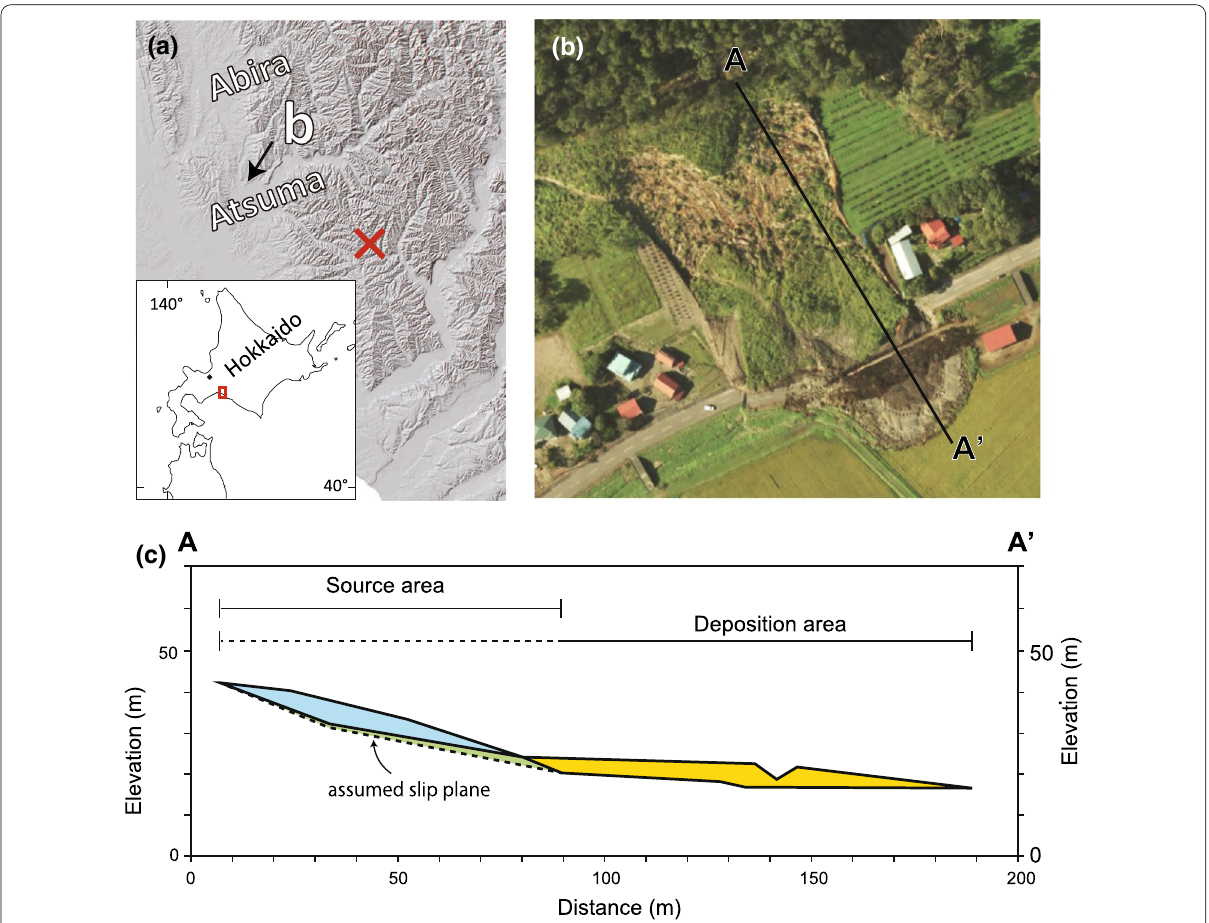
Fig. 1 a Location of the epicenter of the Eastern Iburi earthquake (red cross) and the studied landslide in the Asahi district (42° 44 ′ 10.6 ″ N, 141° 52 ′ 39.8 ″ E; black arrow). b Aerial view of the landslide (taken by the Geospatial Information Authority of Japan 2018). c Cross-section of the landslide based on the field survey by Li and Wang (2020). Soils before and after the failure are marked by light blue and green, and yellow and green,